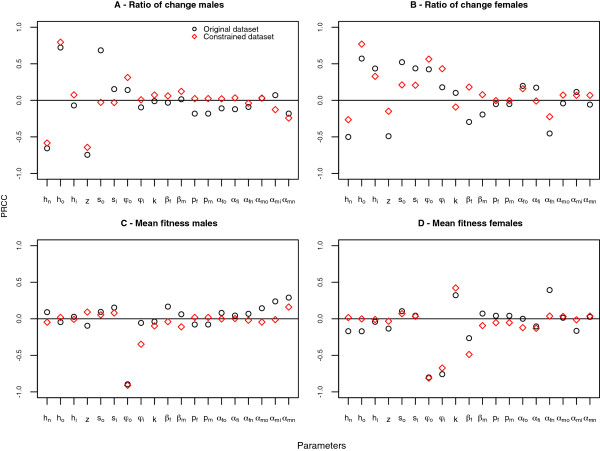
Plot of Partial Rank Correlation Coefficients between each of the parameters in the model and the two outcome variables: mean fitness and ratio of change of resistance allele frequency, in both sexes (above zero increasing positive correlation, below zero increasing negative correlation. The black circles refer to the coefficients calculated using the original dataset and the red diamonds coefficients were calculated using a dataset generated with the constrains: αfn < 0.2, so > 0.5, φi < 0.8, si < 0.5, derived from the classification trees analysis. The parameters symbols in the x-axis are defined in Table
2.